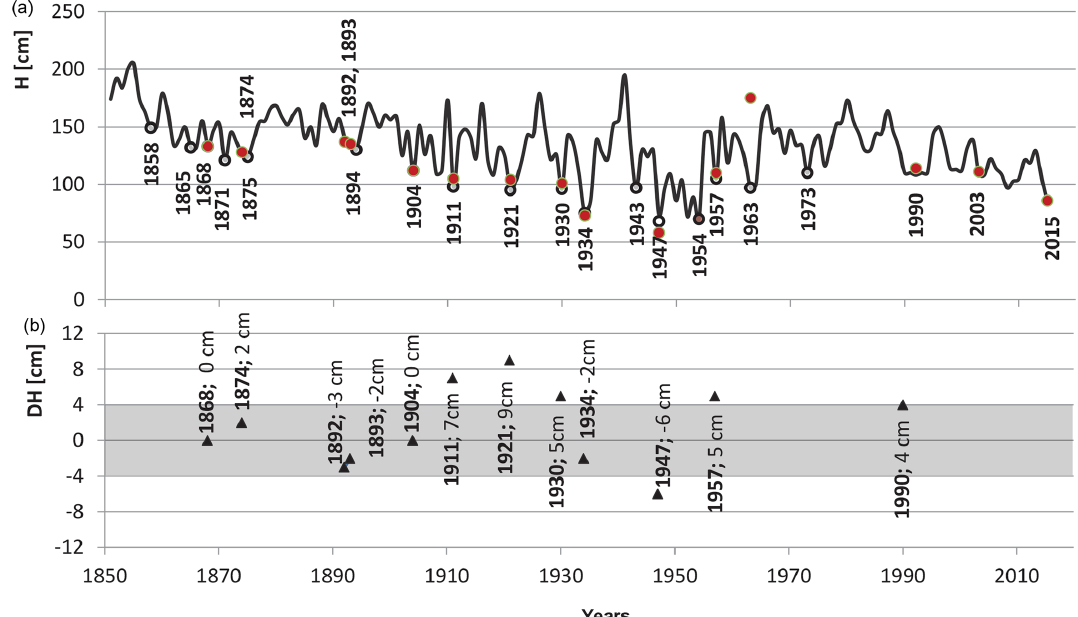
Figure 7. Coincidence of annual water level minima at the Dˇeˇcín station (grey circles) and altitudes measured on the HS1 and HS3 hunger stones in Dˇeˇcín and Dolní Žleb (red circles). H is the water level. DH is the deviations of the marked and measured annual values which are highlighted in the lower part of the graph. The precisely marked height (PMH) with deviations of 0–4cm is highlighted in grey, and the outstanding marks are approximately marked heights (AMH) with deviations of 4–8cm or